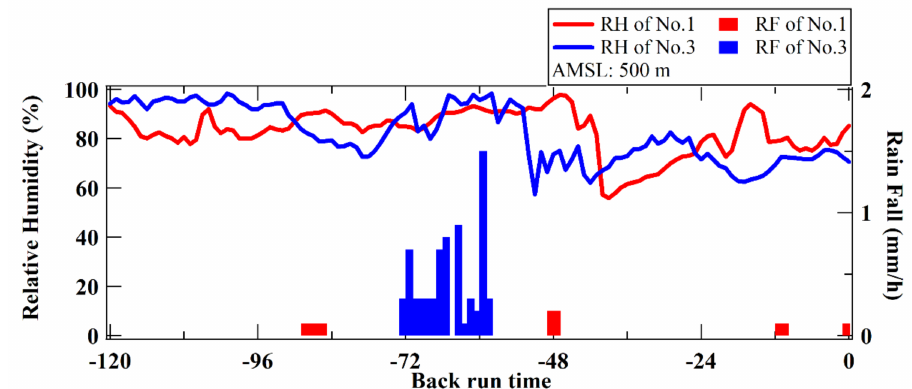
Figure 5. Relative humidity (RH) and rain fall (RF) on the backward trajectories of sample nos. 1 and